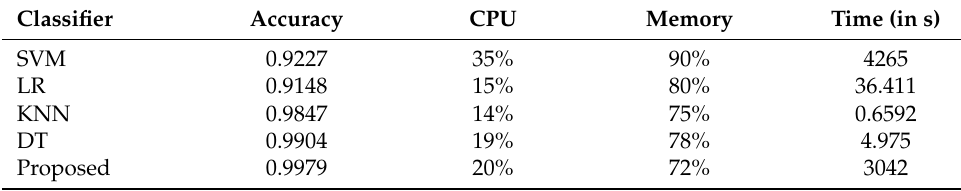
Table 4. Performance comparison of proposed model with other ML